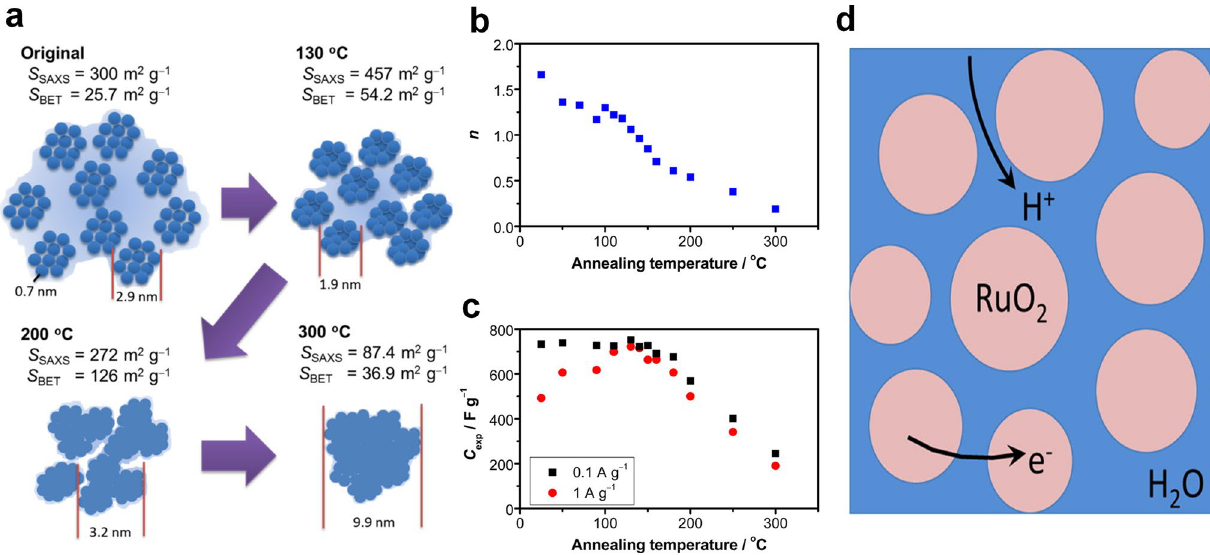
Fig. 3 a The relationship between specific surface area and particle size of RuO 2 ·nH 2 O. b Water molecule content of RuO 2 ·nH 2 O at different annealing temperatures. c Specific capacitance of RuO 2 ·nH 2 O at different annealing temperatures [45]. Copyright 2013, American Chemical Society. d Schematic of proton charge transfer mechanism on RuO 2 surface. Ruthenium, oxygen, and hydrogen ions are shown as blue, red, and pink circles, respectively [46]. Copyright 2013, American Chemical